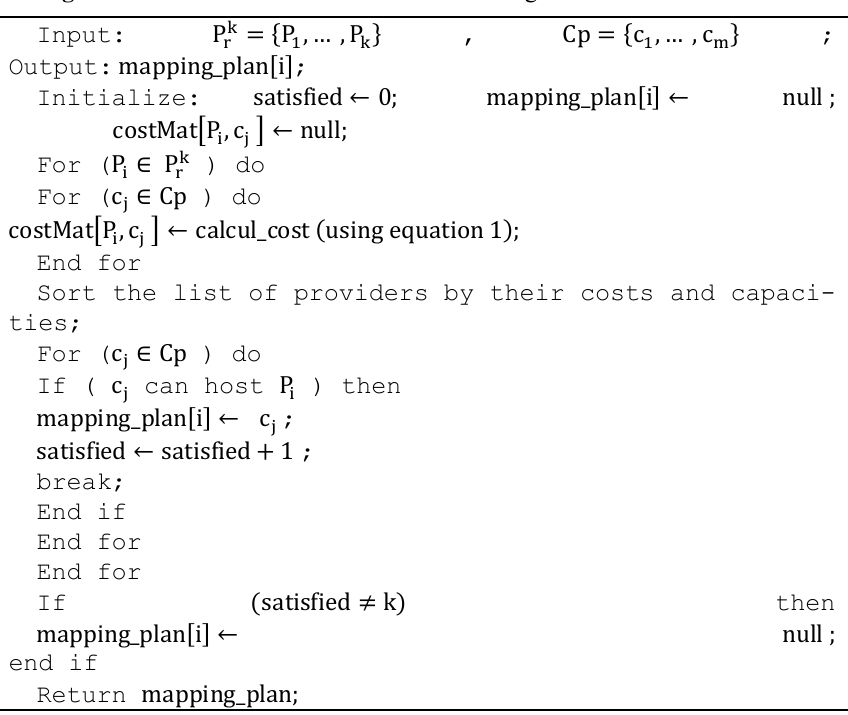
Algorithm 2: Cost-Aware Provider Selection